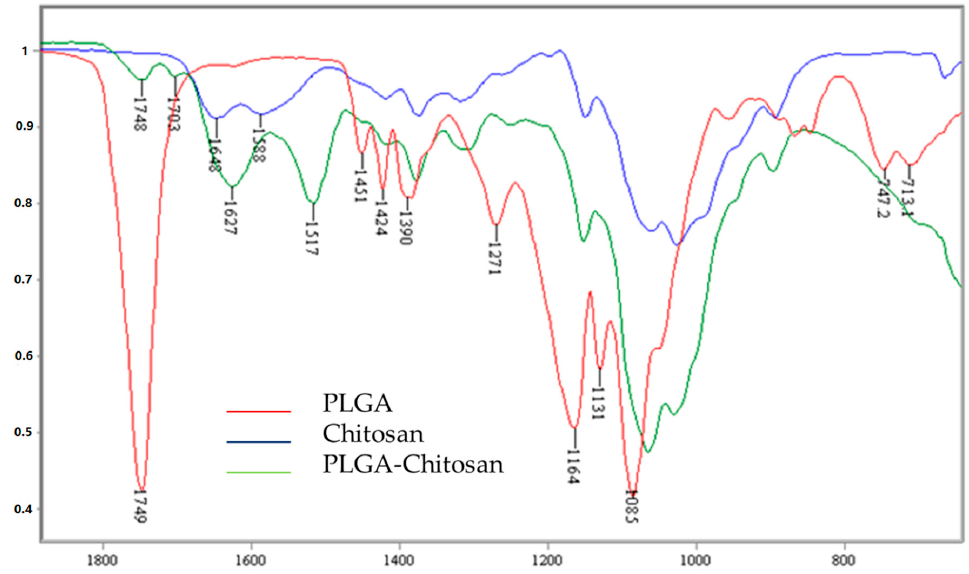
Figure 1. FT-IR / ATR spectra of unmodified poly lactic-co-glycolic acid ( red ), unmodified chitosan ( blue ), and PLGA-chitosan product ( green